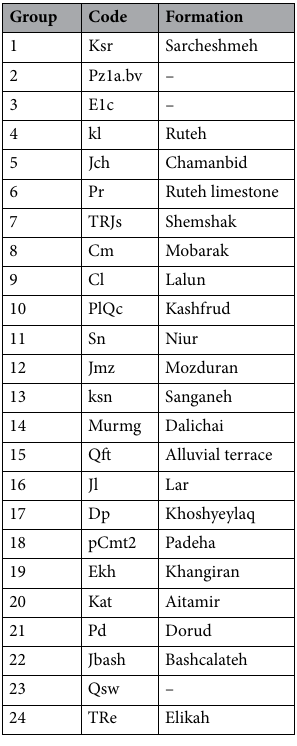
Table 1. Litology of the Gorganrood